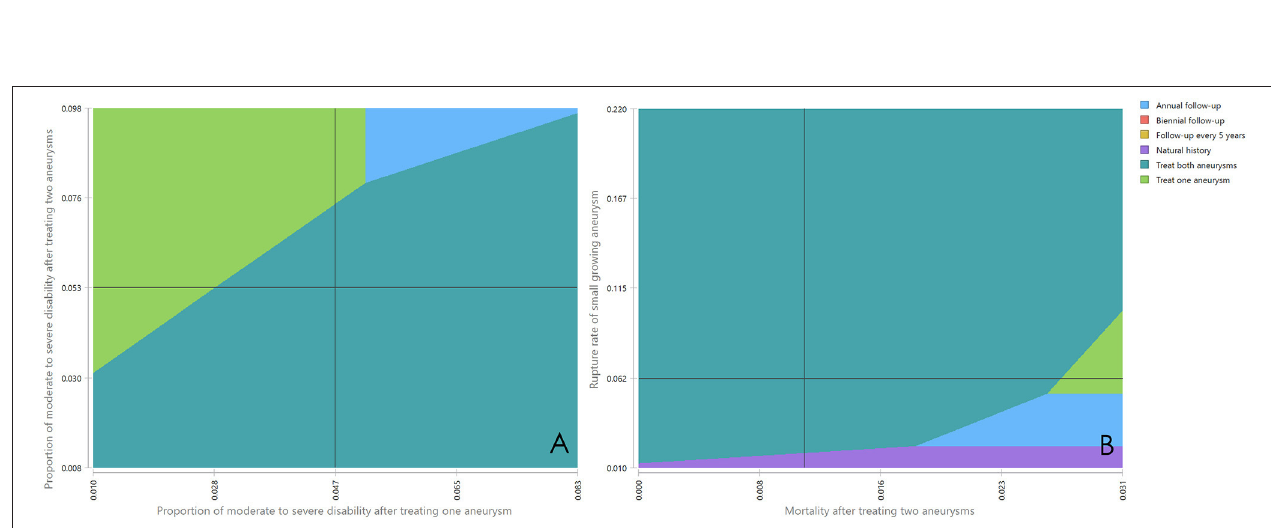
FIGURE 3 | (A,B) Two-way sensitivity analyses. The dark line represents the base case value. The different color areas represent different optimal strategies.